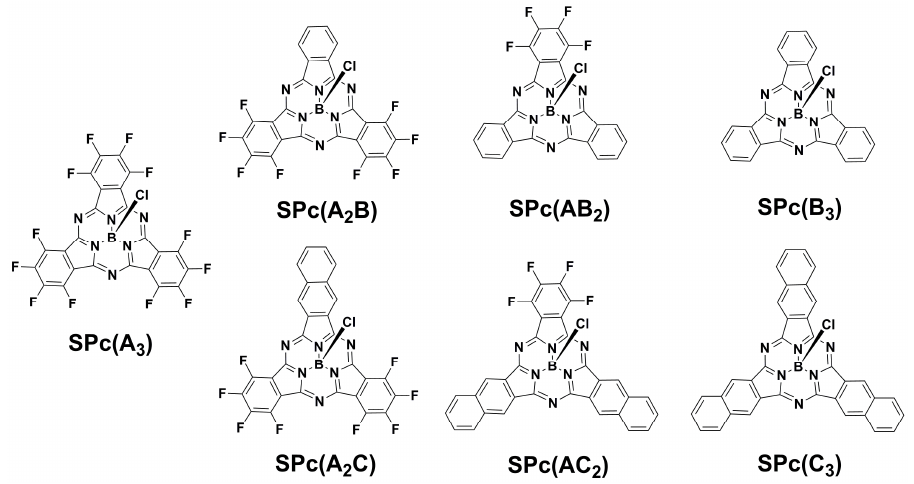
Figure 1. Mixed fluorinated boron subphthalocyanines (SPcs).